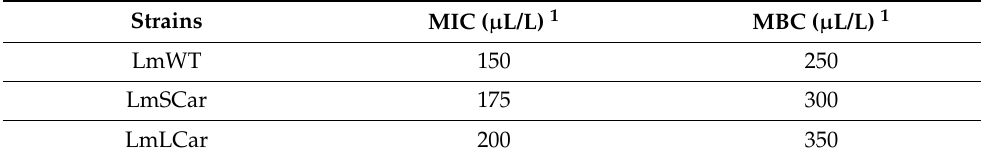
Table 1. Minimum inhibitory concentration (MIC; µ L/L) and minimum bactericidal concentra- tion (MBC; µ L/L) of carvacrol for Listeria monocytogenes EGD-e (LmWT) and the selected evolved strains: LmSCar (exposed to prolonged sublethal doses) and LmLCar (cyclically exposed to short lethal